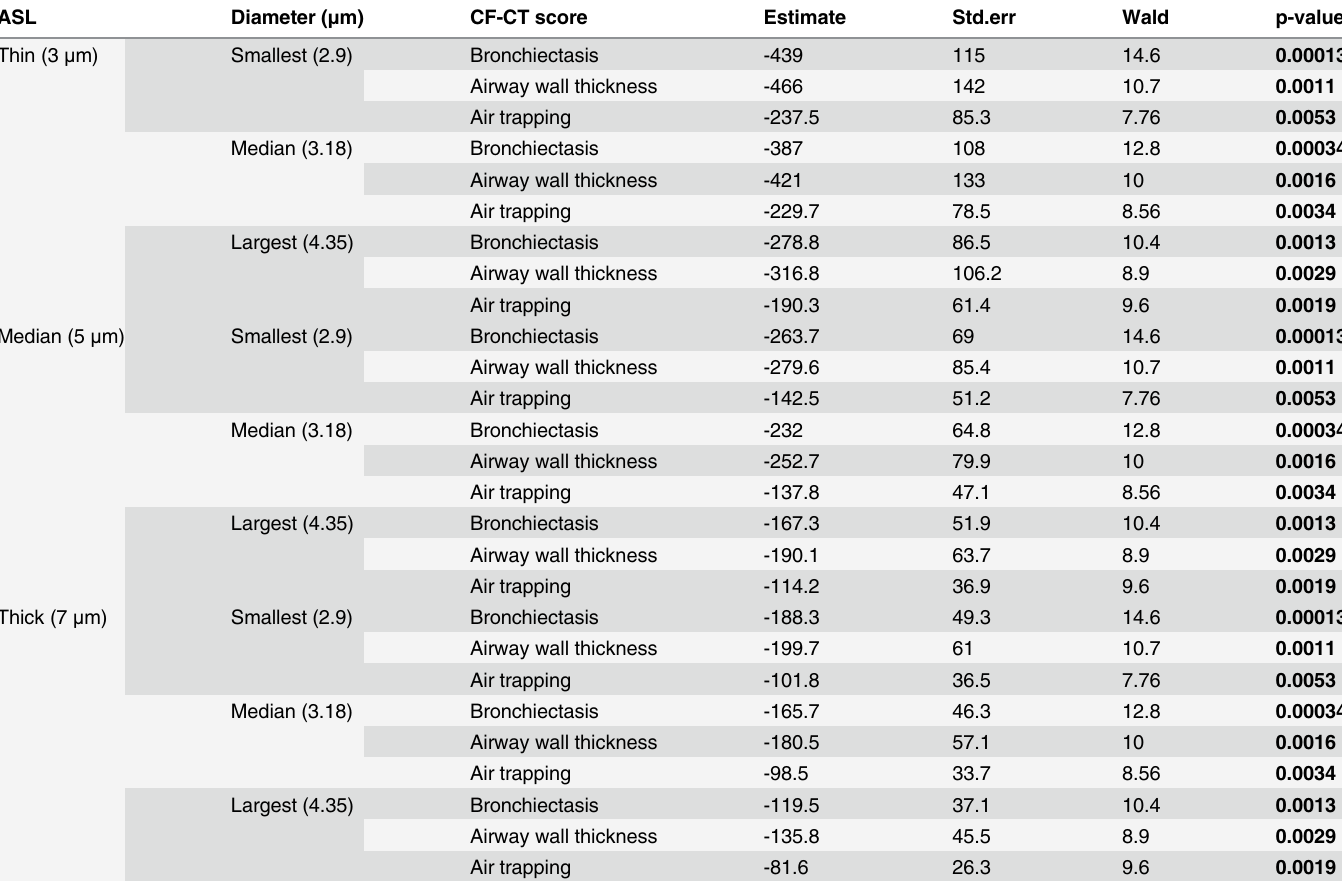
Table 2. Inverse correlation between AZLI concentration in a lobe and the CF-CT scores.